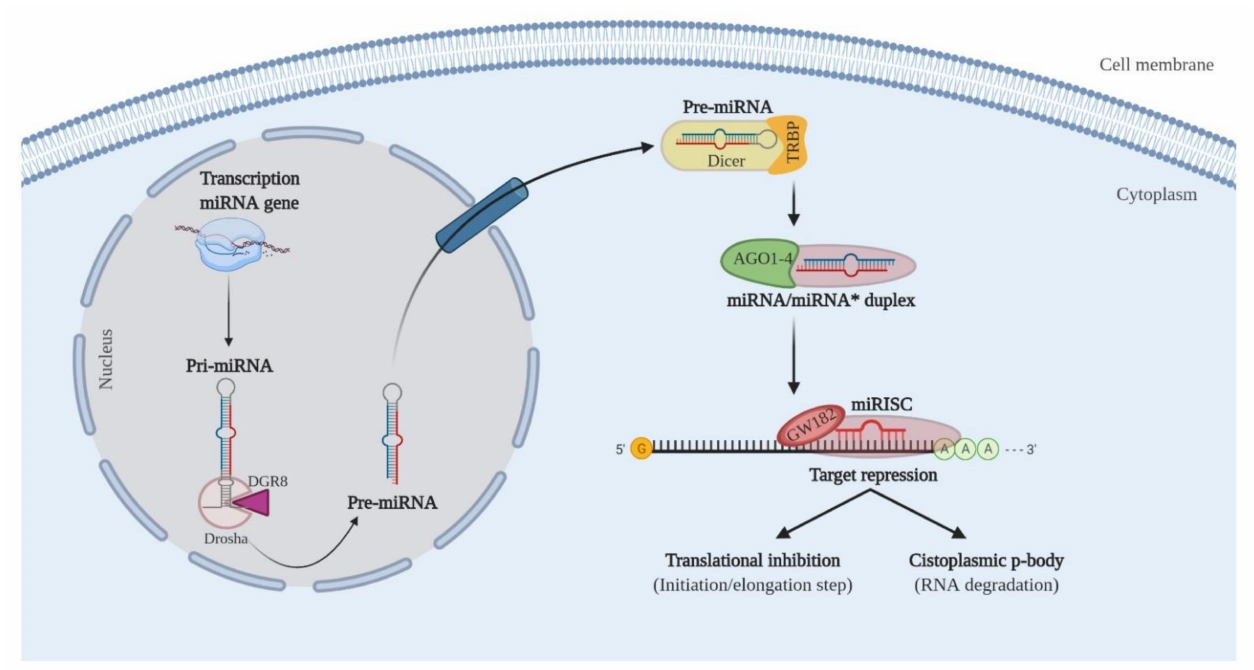
Figure 2. Biogenesis and modulation of microRNA